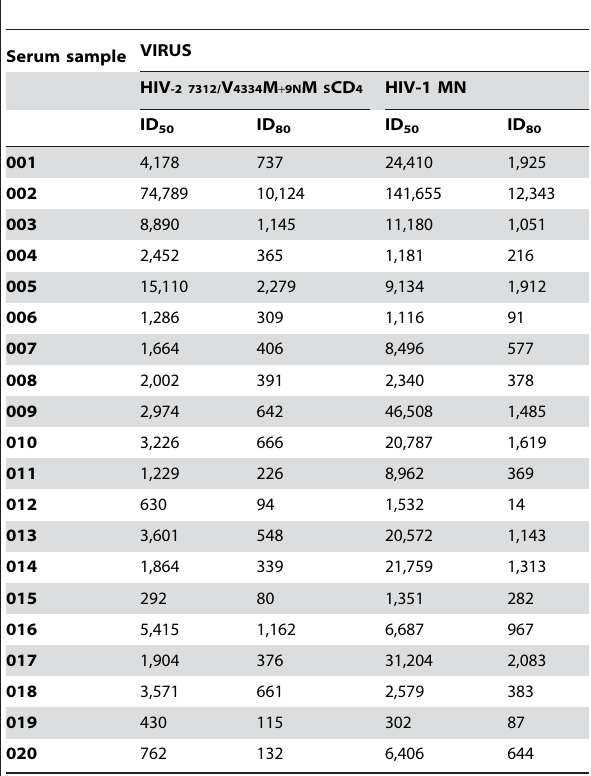
Table 1. Neutralization values present in sera elicited by gp120 inoculated into humans